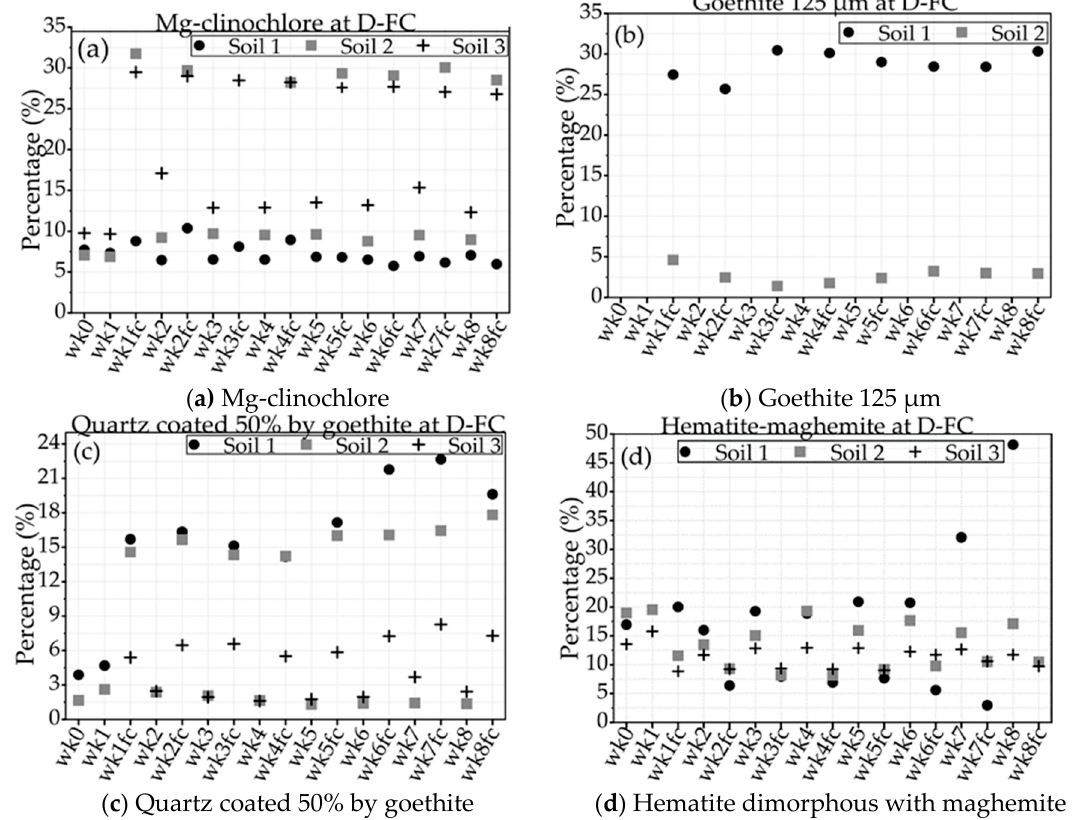
Figure 6. The average percentage of Mg-clinochlore ( a ), goethite 125 µ m ( b ), quartz coated 50% by goethite ( c ) and hematite dimorphous with maghemite ( d ) changes for all the soils at the D-FC treatment. The circle, square and plus symbols represent Soil 1, Soil 2, and Soil 3, respectively. The vertical axis characterizes the percentage of each mineral occurring in an image. The scale of the Y-axis varies from 0% to 100%. In the horizontal axis, wk1,...,wk8 stands for week 1,...,week 8, when the soil sample was at the dry conditions. Since the soil samples were at the field capacity every three days, wk1fc,..., wk8fc (week 1fc,...,week 8fc) was used to represent it.